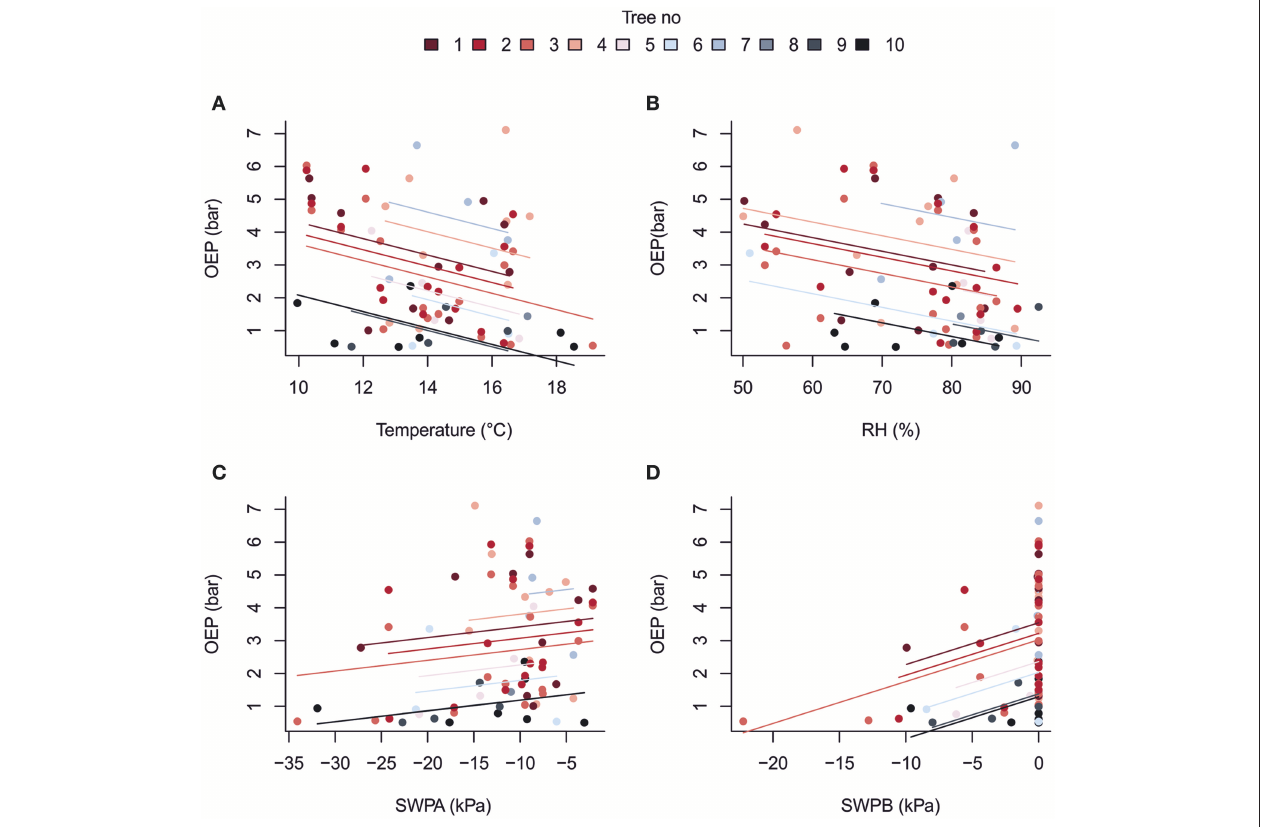
FIGURE 4 | Repeated measures correlation for the overall relationship between three-day averages of oleoresin exudation pressure (OEP) measured two or more times in ten mature Scots pines and (A) ambient temperature at 16m, (B) relative humidity at 16m, (C) soil water potential in A horizon and (D) soil water potential in B horizon at the SMEAR II station in summer